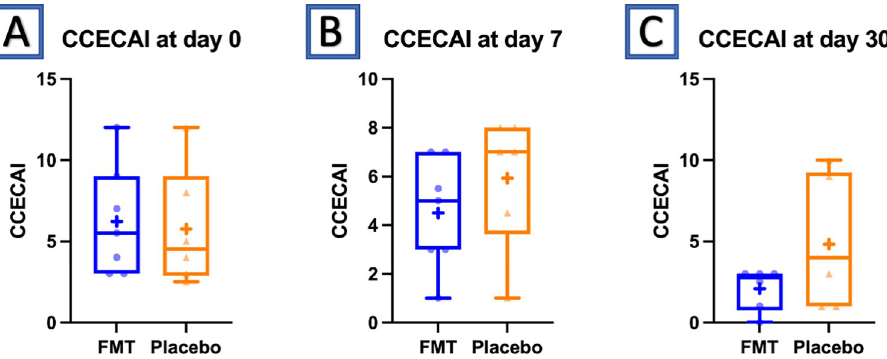
Fig 2. Box and whisker plot of the CCECAI at baseline, day 7 and day 30 in dogs that received placebo or